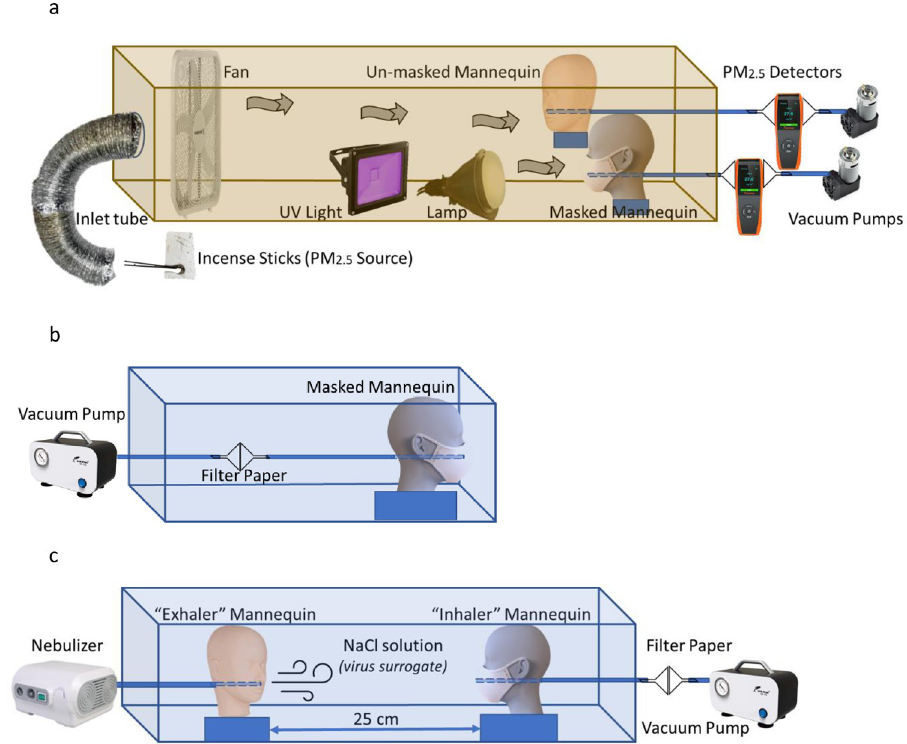
Fig 3. a. The PFE experimental set-up included a wind tunnel with a fan to create the draft, incense sticks to simulate the PM 2.5 , laser particle detectors to measure the filtration efficiency between masked and unmasked mannequins, with vacuum pumps providing the negative pressure for breathing simulation. b. The NRE experimental set-up, with a vacuum pump simulated 8 hours of continuous breathing and a fine (pore Ø 9 nm) filter paper collected dislodged nanoparticles from the coated masks. c. VFE set-up with an “inhaler” mannequin in front of another mannequin exhaled nebulized NaCl particles as a surrogate for virions encased in respiratory